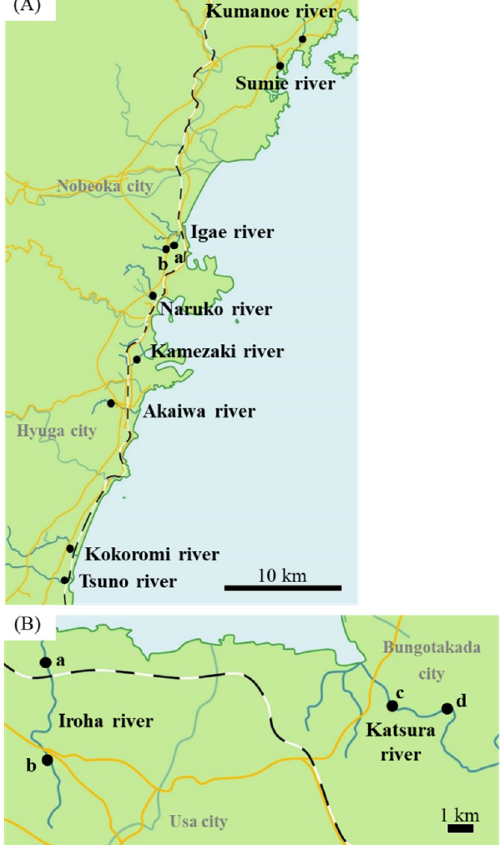
Figure 1. Sampling area. ( A ) Sampling area in Miyazaki River. In the Igae River, samples were collected from two locations (a, b). ( B ) Sampling area in Oita River. In Iroha and Katsura rivers, samples were collected from two locations (Iroha River: a, b. Katsura River: c, d.). Closed circles represent sampling areas. Scale bar: 10 km ( A ); 1 km ( B ).